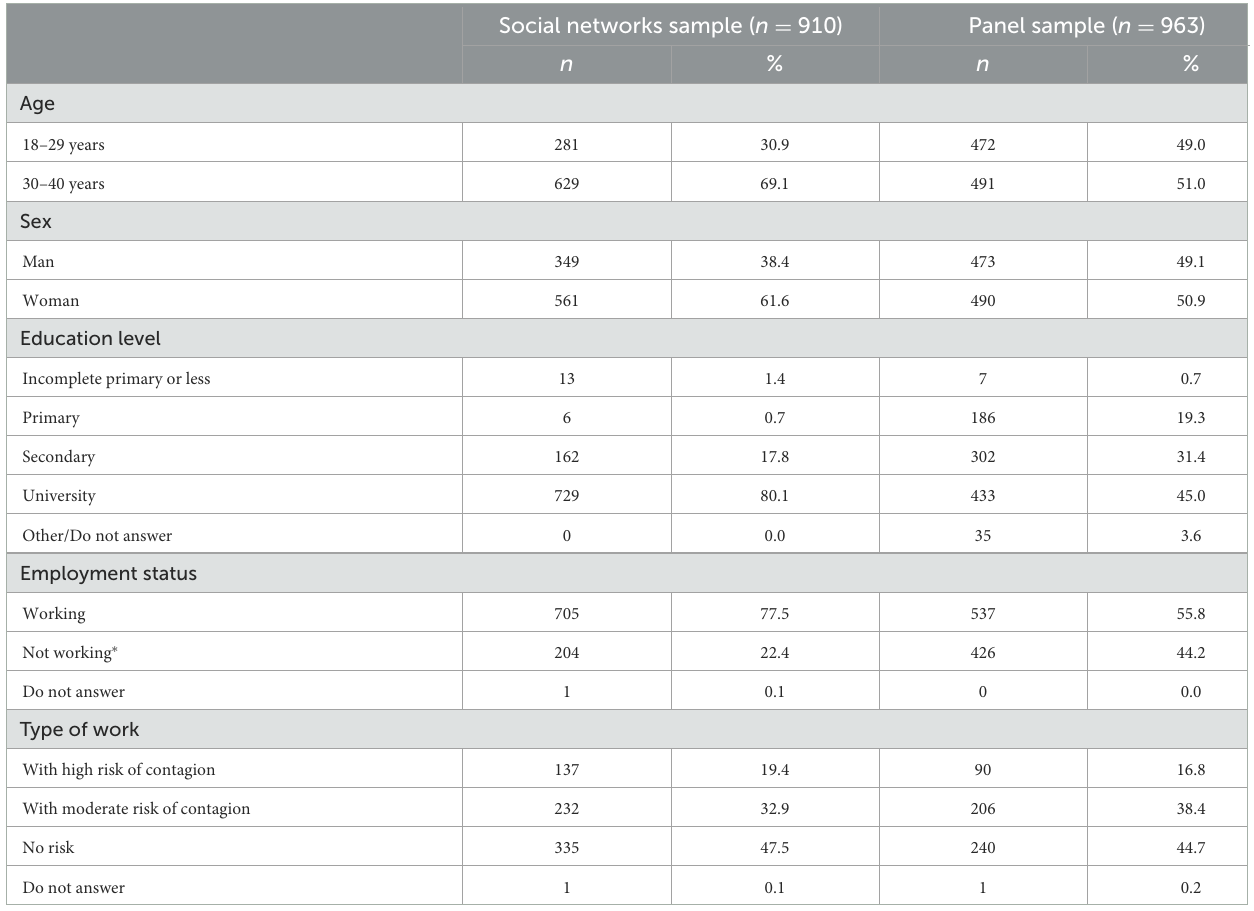
TABLE 1 Socio-demographic characteristics of the samples.